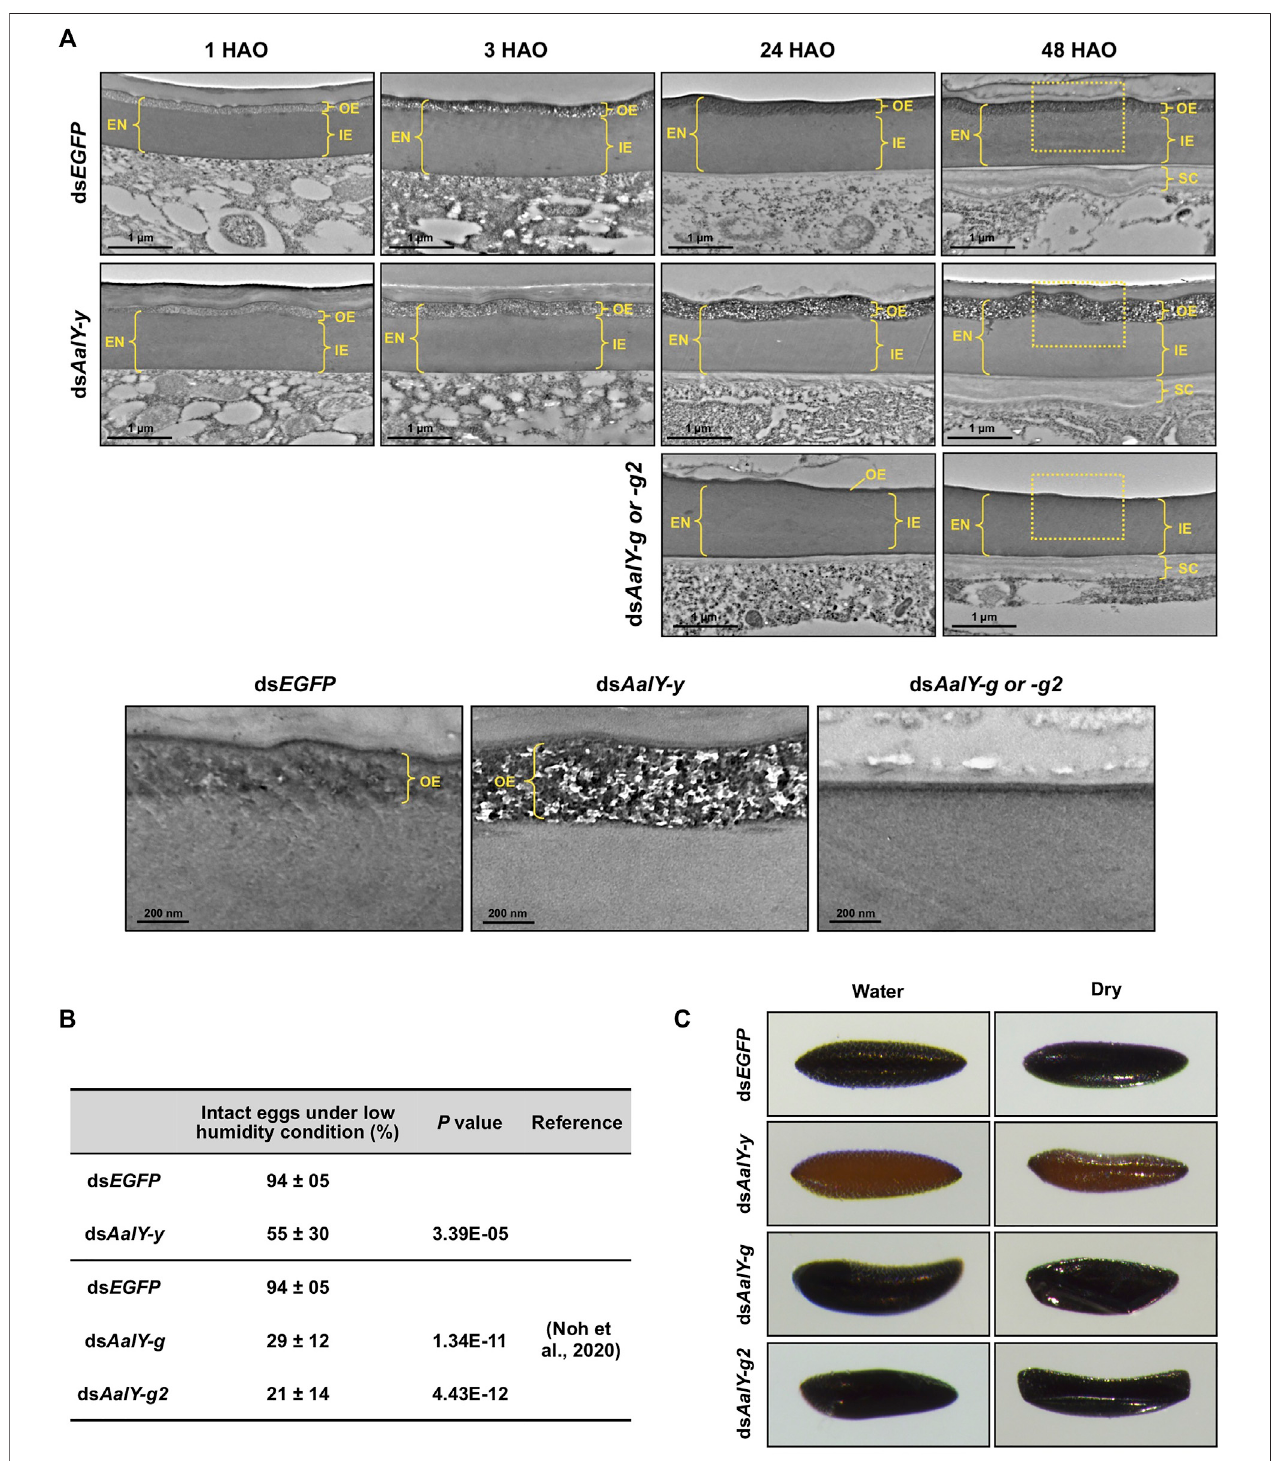
FIGURE 4 | Ultrastructure of eggshell and resistance to desiccation of ds AalY-y eggs. (A) Ultra-thin sections ( ∼ 90 nm) of 1, 3, 24 and 48 h after oviposition (HAO) eggs from ds AalY-y or ds EGFP -treated females were prepared for analysis of the ultrastructure of the eggshell by TEM. The outer-endochorion (OE) layer of ds EGFP eggs exhibited an electron-lucent spotty morphology at one HAO, which became electron-dense with obscure morphology by 24 HAO. In contrast, the OE of ds AalY-y eggs remained electron-lucentat threeHAO andexhibitedanelectron-lucentand electron-densespottymorphologyat 24and 48HAO.Representativeimagesof 24 and 48 HAO eggs from either ds AalY-g - or ds AalY-g2 -treated insects were also shown. Little or no electron-denseOEwas evident in those eggs. Theouter portions ofthe48HAOeggs(boxed)areenlargedinthebottompanels.EN,endochorion;OE,outerendochorion;IE,innerendochorion;SC,serosalcuticle. (B) Eggresistanceto desiccationwasanalyzedat48HAO.Dataareshownasthemeanvalue ± SE(300 – 400eggsobtainedfrom13to15femaleadults). (C) The48HAOeggsbefore(Water) and after 30 min under low humidity condition (Dry) are shown. Frontiers in Cell and Developmental Biology |